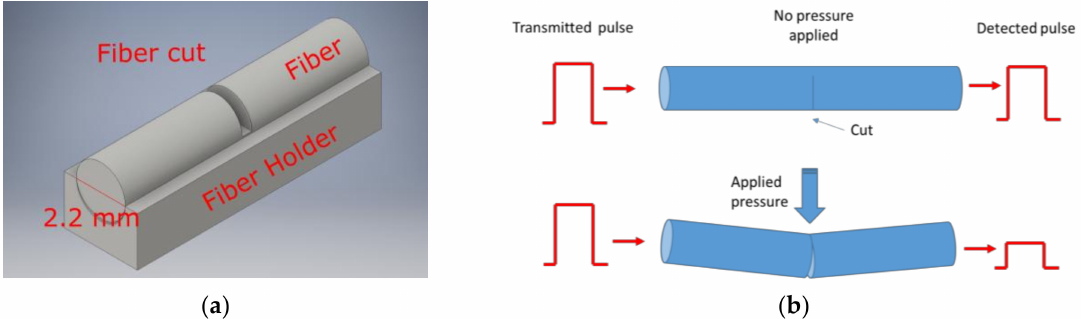
Figure 1. ( a ) 3D model of the plastic holder used to cut the fibers. The hemicylindrical groove has the same diameter as the plastic fiber to limit the penetration of the blade into the fiber and obtain similar cuts of approximately 1.1 mm (half of the fiber diameter) depth. ( b ) Working principle of a single point of the fiber